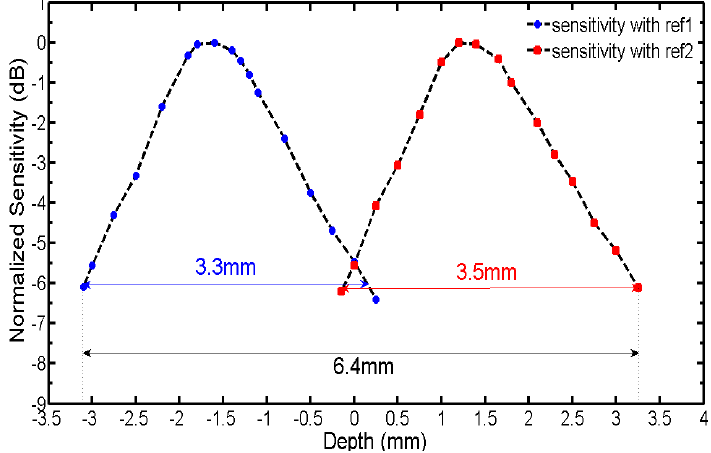
Figure 5. The measured sensitivity curves corresponding to the Reference Arm I [1] and Reference Arm II [2].